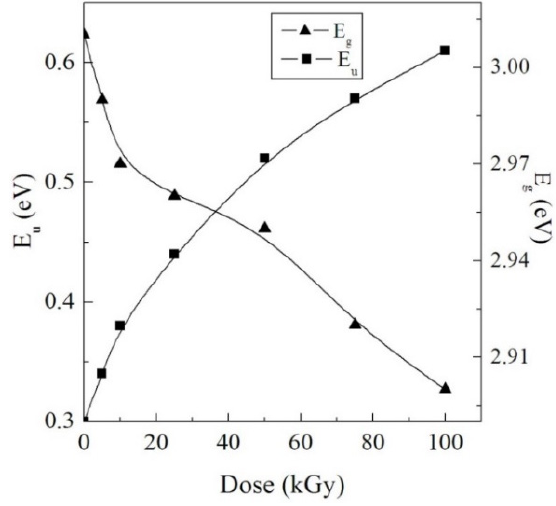
Figure 8. A Plot of ( α h ν ) 0.5 against h ν for the pristine and irradiated NC films. Figure 8. Variation of the E u and E g with the γ